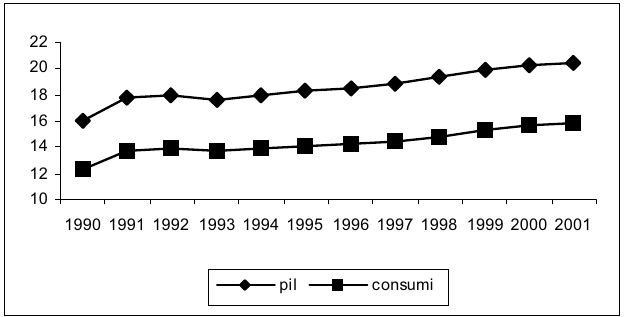
Figura 1 – Prodotto interno lordo e consumi finali nazionali pro capite dal 1990 al 2001 nei paesi dell’area dell’EURO – dati annuali a prezzi 1995, migliaia di